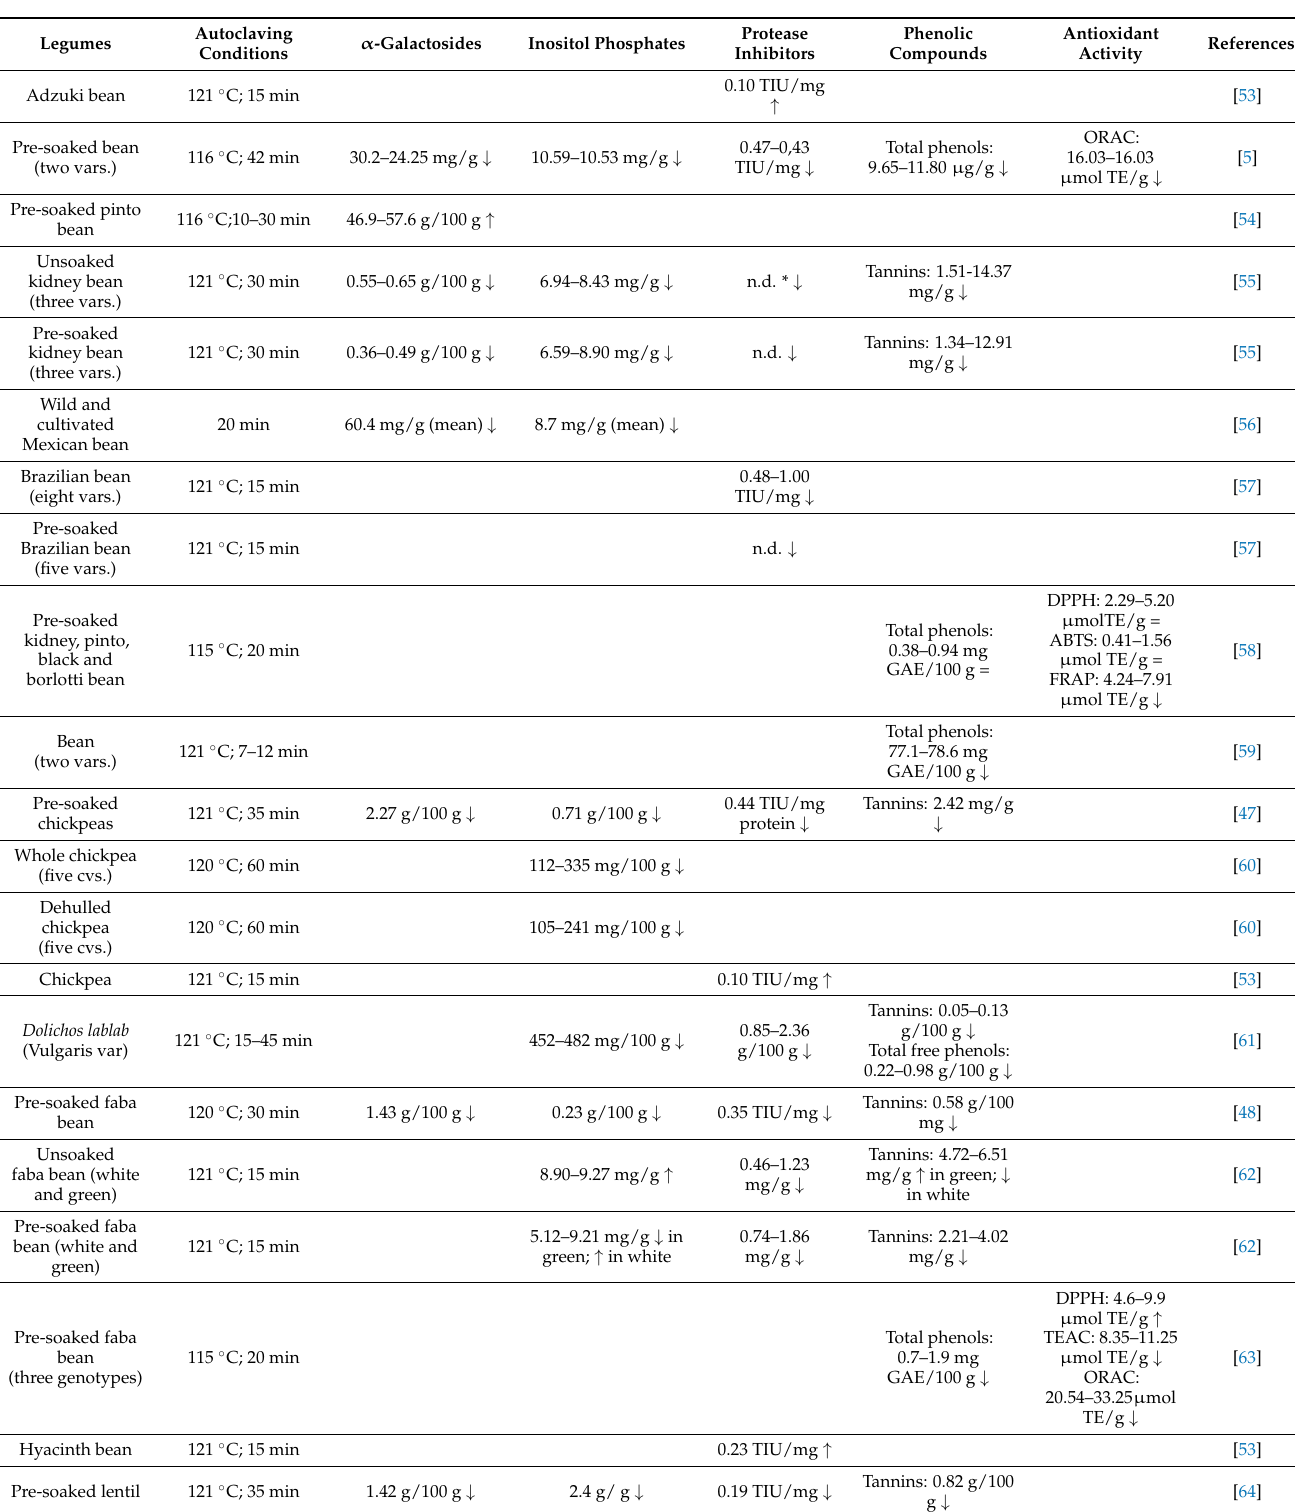
Table 1. Content of different bioactive compounds ( α -galactosides, inositol phosphates, protease inhibitors, phenolic compounds and antioxidant activity) in autoclaved